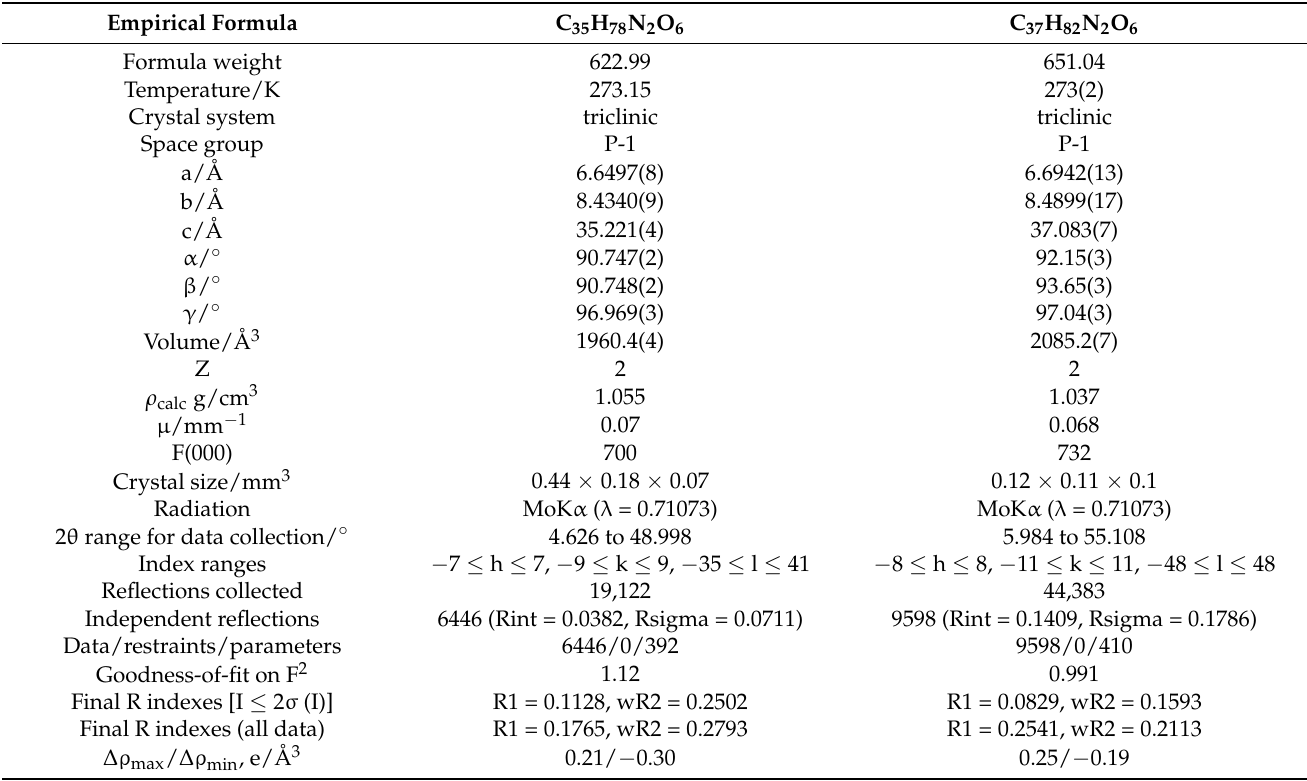
Table 1. Crystal data and structure refinement for 3C16 and 3C17.